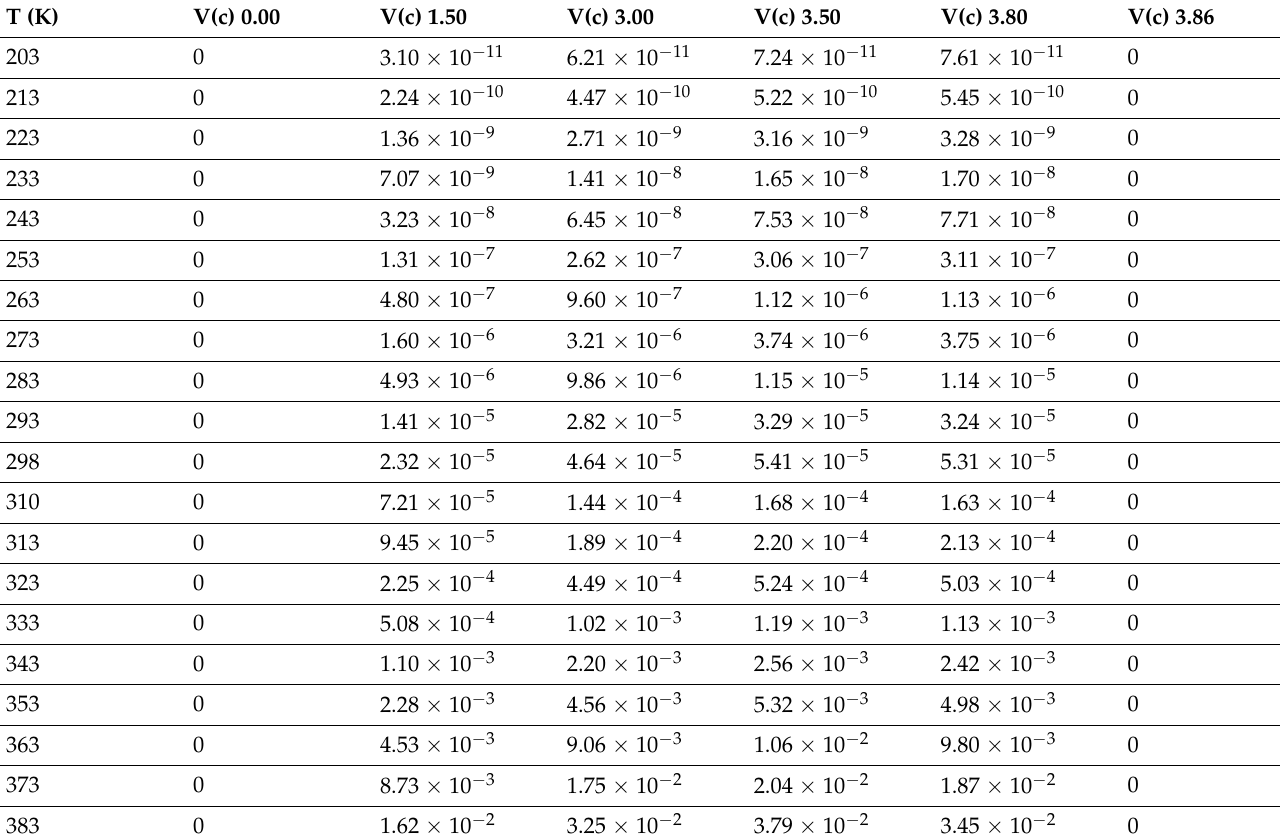
Table 2 list the computed isothermal electricity power production density defined as Watt (W) per square centimeters (W/cm 2 ) as a function of operating temperature T in a range from 203 K ( − 70 ◦ C) to 673 K (400 ◦ C) at a number of output voltage V(c) values including 0.00, 1.50, 3.00, 3.50, 3,80 and 3.86 V, as calculated using Equation (12) for a pair of emitter electron-work function (WF(e) = 0.70 eV) and collector electron-work function (WF(c) = 4.56 eV, copper Cu(110)) where the emitter was grounded. The data showed that the output voltage V(c) that gave the best isothermal electricity power production density (W/cm 2 ) was about 3.50 V in this example. The isothermal power production density (W/cm 2 ) at output voltage V(c) of 3.50 V is strongly dependent on temperature T, which is in a range from 7.24 × 10 − 11 (W/cm 2 ) at 203 K ( − 70 ◦ C) to 5.41 × 10 − 5 (W/cm 2 ) at 298K (25 ◦ C), and to as much as 1090 (W/cm 2 ) at 673 K (400 ◦ C). Table 2. Presents the computed isothermal electricity power production density defined as Watt (W) per square centimeters (W/cm 2 ) as a function of operating temperature T at various output voltage V(c) from 0.00 to 3.86 V, calculated using Equation (12) for a pair of emitter electron-work function (WF(e) = 0.70 eV) and collector electron-work function (WF(c) = 4.56 eV, copper Cu(110)) where the emitter is